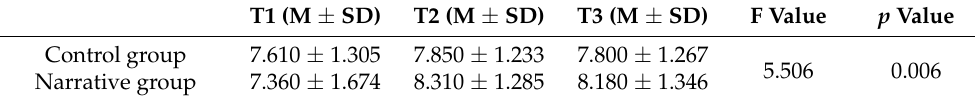
Figure 1. Two-way repeated-measures ANOVA of children’s environmental knowledge . Table 6. Two-way repeated-measures ANOVA of children’s environmental knowledge .